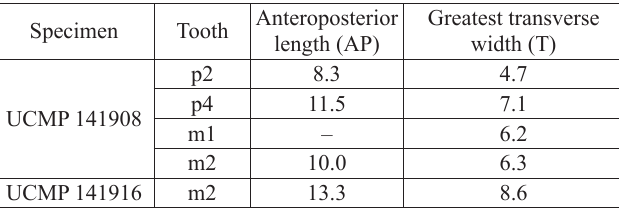
Table 2. Measurements (in mm) of Tomarctus brevirostris teeth from Eastgate, Nevada, USA; lower Monarch Mill Formation, Barstovian